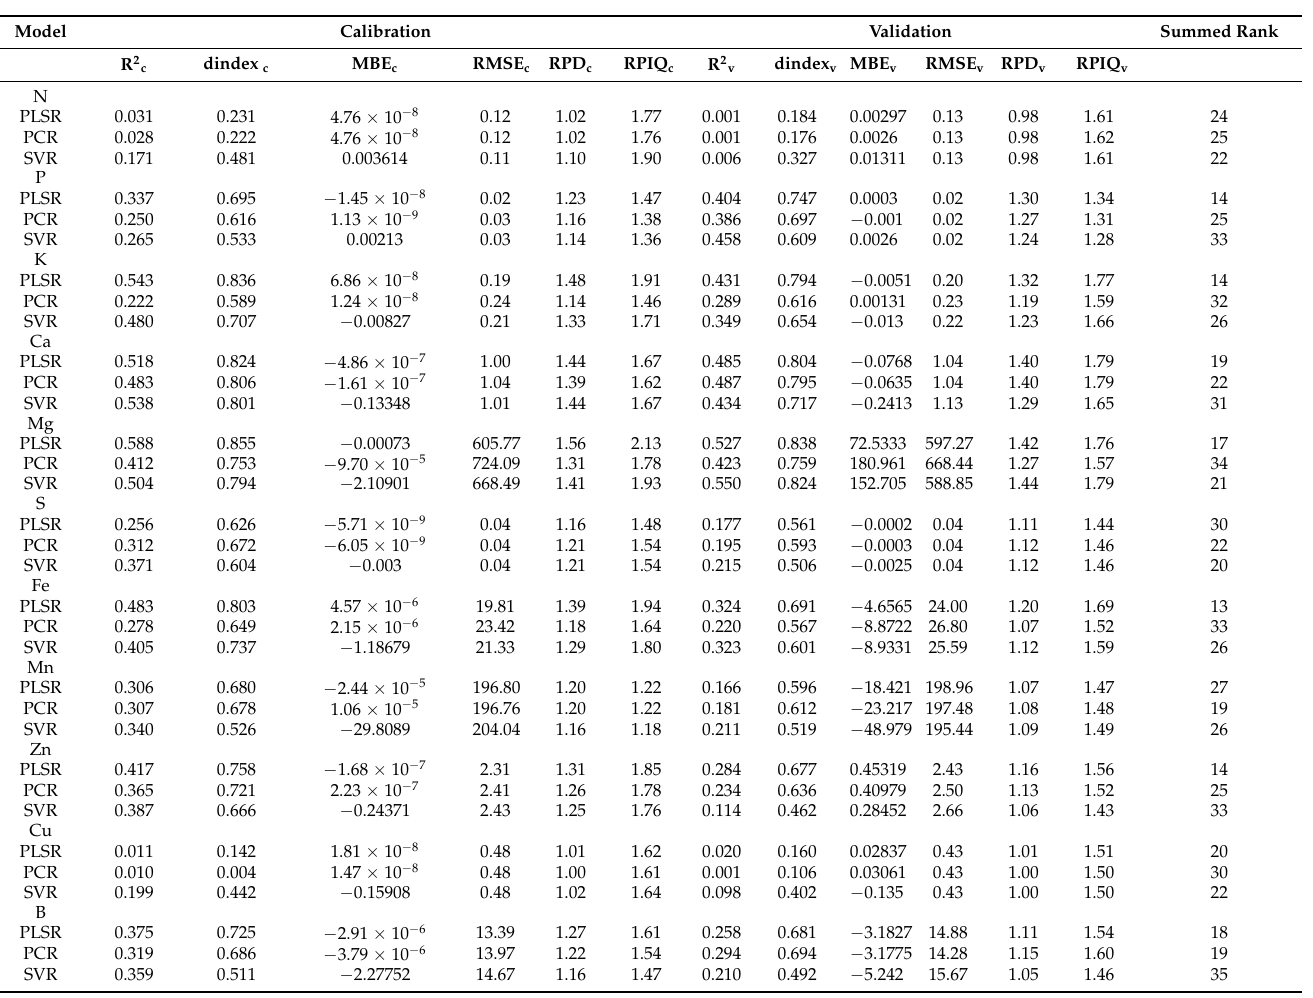
Table 4. Performance of the multivariate analysis models for calibration and validation to predict the mango leaf nutrient